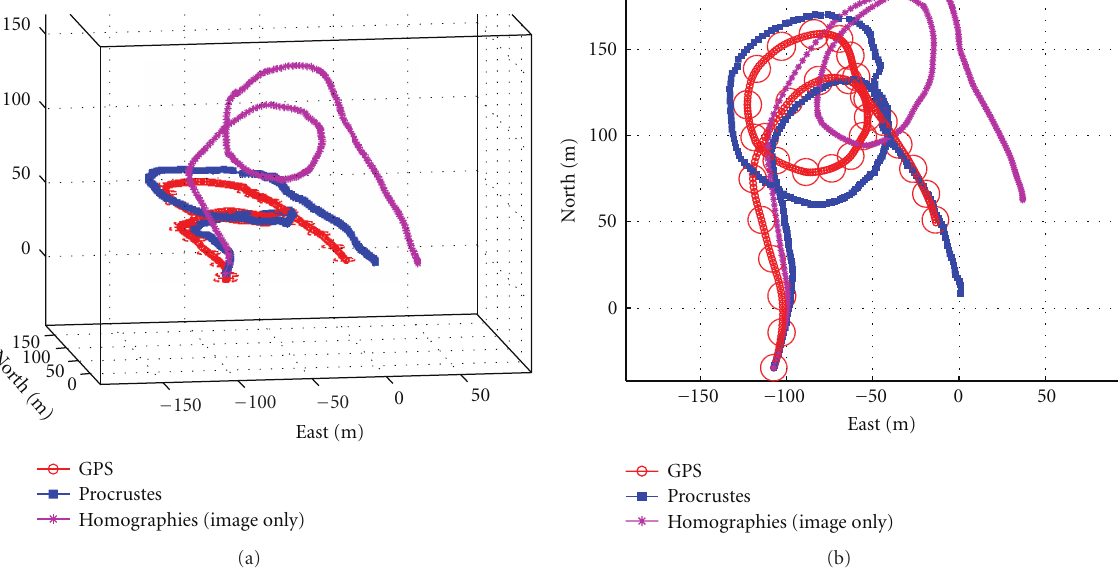
Figure 7: 3D (a) and 2D (b) plots comparing visual odometry with GPS position fixes. The circles indicate some of the GPS eph values (i.e., one standard